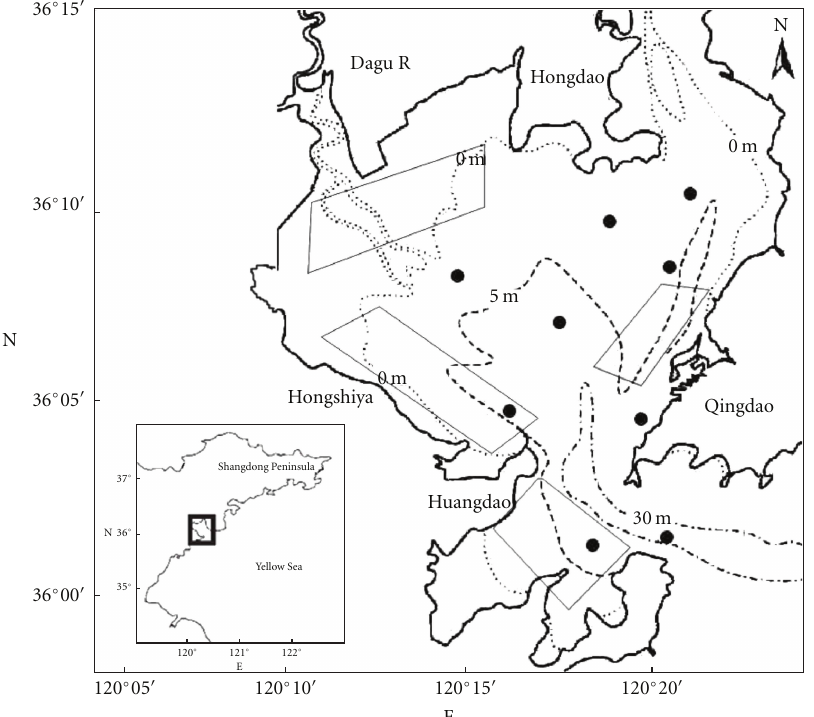
Figure 1: Map of Jiaozhou Bay showing sampling sites (dots) (quadrilaterals with solid and dotted lines were regions for clam and scallop aquaculture, resp. in the 1990s).